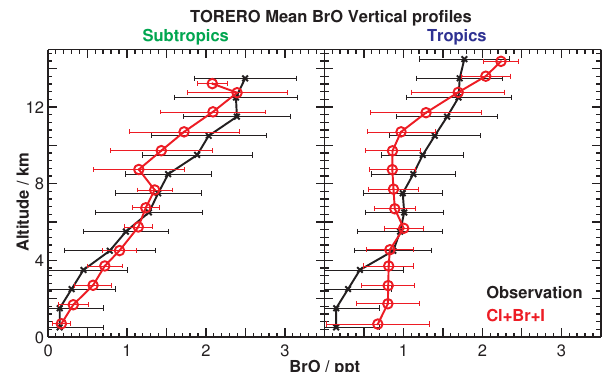
Figure 11. Vertical comparison of the model (“Cl + Br + I”) and measured bromine oxide (BrO) during TORERO aircraft campaign (Volkamer et al., 2015; Wang et al., 2015) in the subtropics (left) and tropics (right). Model and observations are in red and black, re- spectively. Observations and modelled values at the same location and time (as described in Sect. 2) are shown side-by-side around the midpoint of each bin. Measurements were taken aboard the NSF/NCAR GV research aircraft by the University of Colorado airborne multi-axis DOAS instrument (CU AMAX-DOAS) in the eastern Pacific in January and February 2012 (Volkamer et al., 2015; Wang et al., 2015). Locations of observations are shown in Fig.